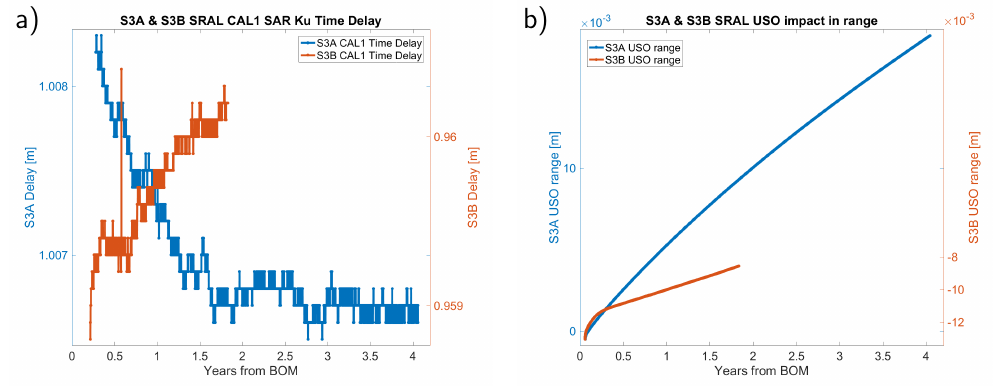
Figure 4. S3A and S3B whole mission series of calibration parameters correcting science range measurements: ( a ) calibration path time delay, and ( b ) range delay due to not-nominal Ultra-Stable Oscillator